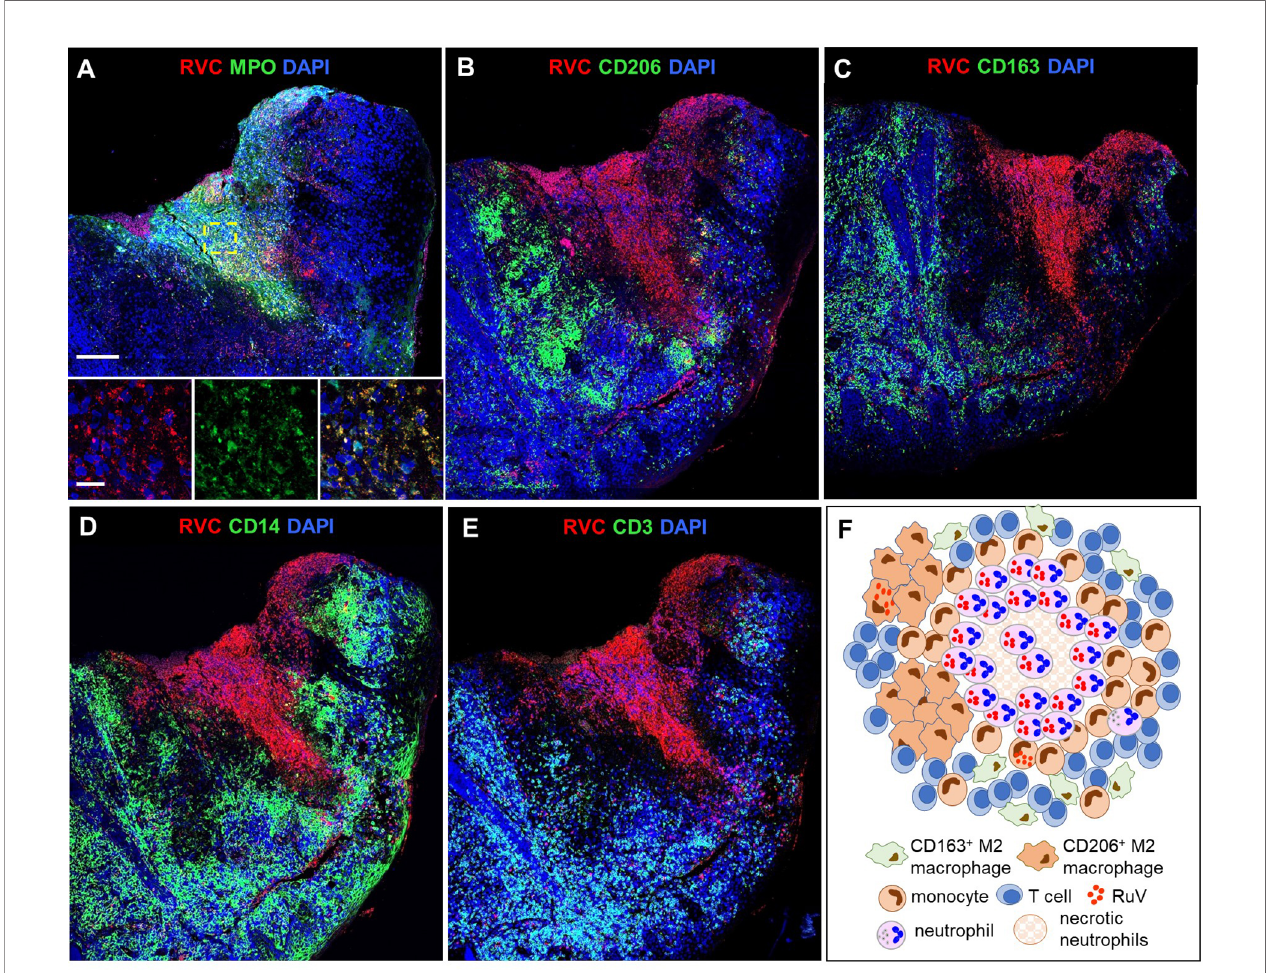
FIGURE 4 | A structure of N-type RuV-associated cutaneous granuloma and its cellular elements. Histological double immuno fl uorescent staining of sequential tissue sections of skin biopsy (P21) for RVC (red) and one of the cell type markers (green) shows predominant RVC staining of MPO + neutrophils (A) , infrequent RVC staining of CD206 + M2 macrophages (B) , CD163 + M2 macrophages (C) , and CD14 + monocytes (D) . Numerous RVC - CD3 + T cells surround the RVC + neutrophil core (E) . Scale bars: 200 µm and 20 µm (inlet). Schematic of N-type RuV-associated granuloma pattern (F)